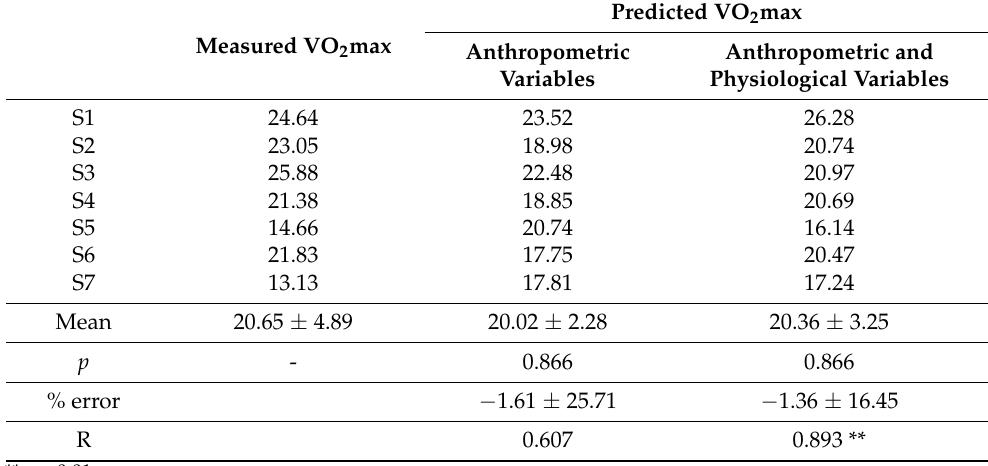
Table 4. Measured and predicted VO 2 max (mL/min/kg) from maximal graded exercise